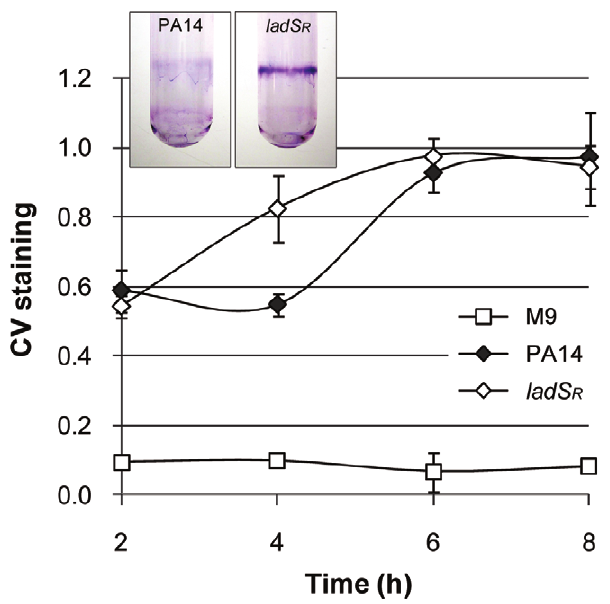
Figure 2. Biofilm formation. Biofilm formation of PA14 and ladS R in M9 medium. Graph: Biofilm formation in 24-well polystyrene plates at 37 u C in shaking conditions. Inset: Crystal violet stained biofilms in glass tubes after 8 h incubation at 30 u C. Data is representative of at least two